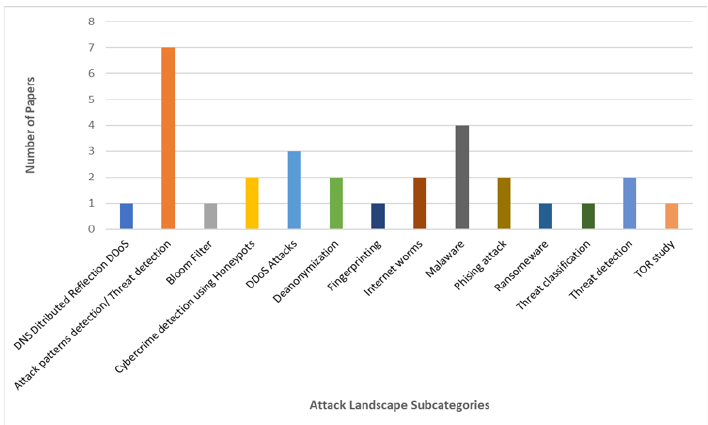
Figure 6. A snapshot of different attack vectors discussed by prior researchers with the distribution of papers for each subcategory.